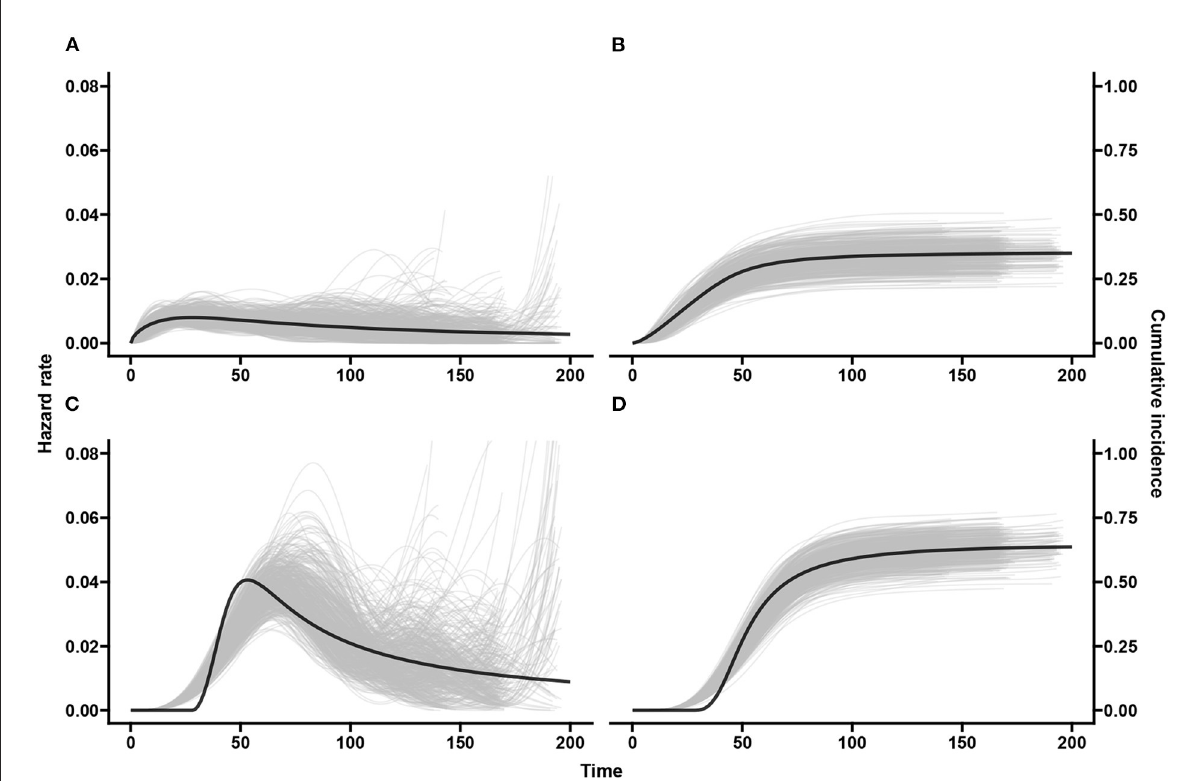
FIGURE6 Scenario 1: Baseline hazards and cumulative incidences across simulations. The black line shows the true hazards (A,C) and true cumulative incidences (B,D) for the event of interest (A,B) and competing/clearance event (C,D) . The gray curves show estimates from our spline based model applied on the doubly-interval-censored data for all 500 simulated